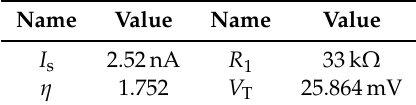
Table 4. Simulation parameters for a single folding stage in the middle Serge Wave Multiplier.